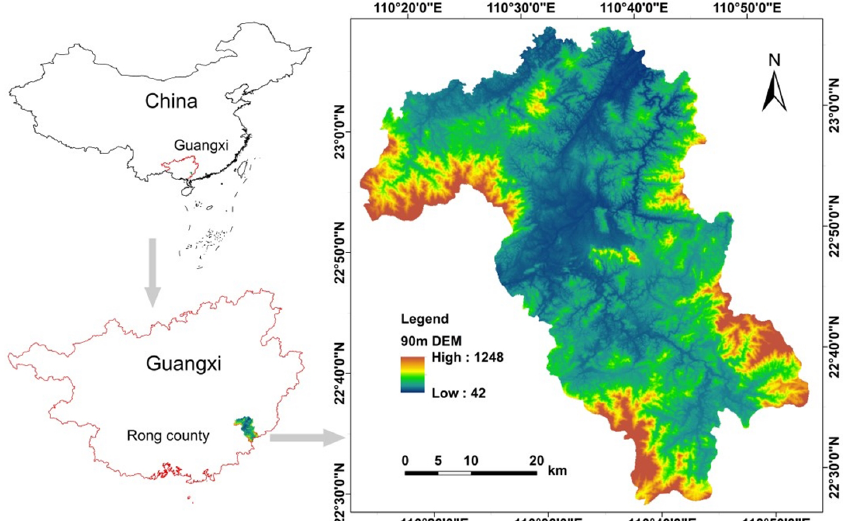
Figure 1. Study area.